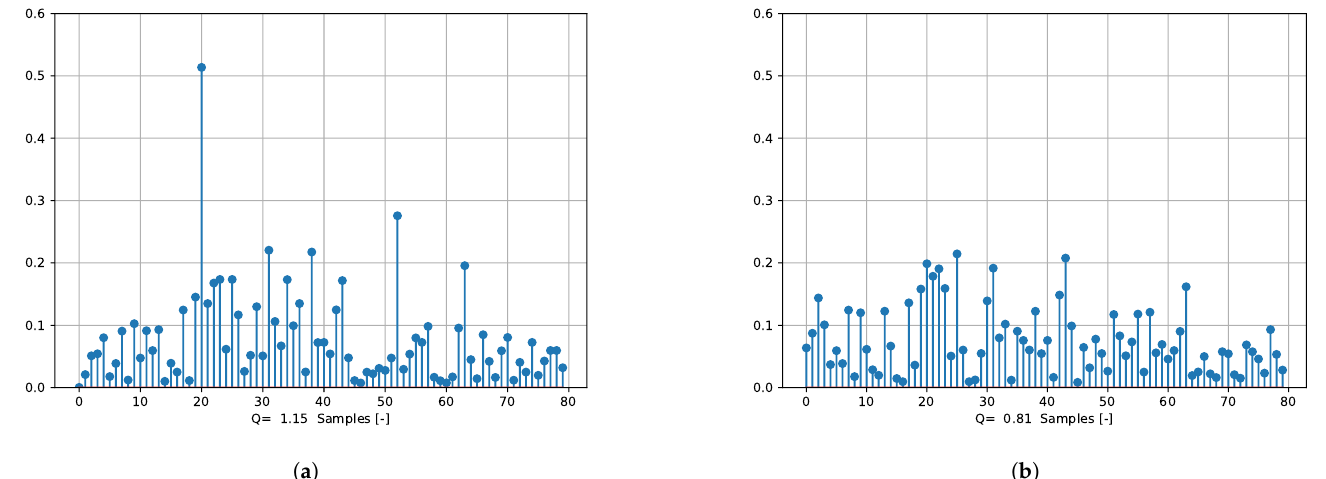
Figure 10. Single shaft rotation (electric angle), sine, and cosine estimation error. ( a ) Using a single ANN. ( b ) Using multiple